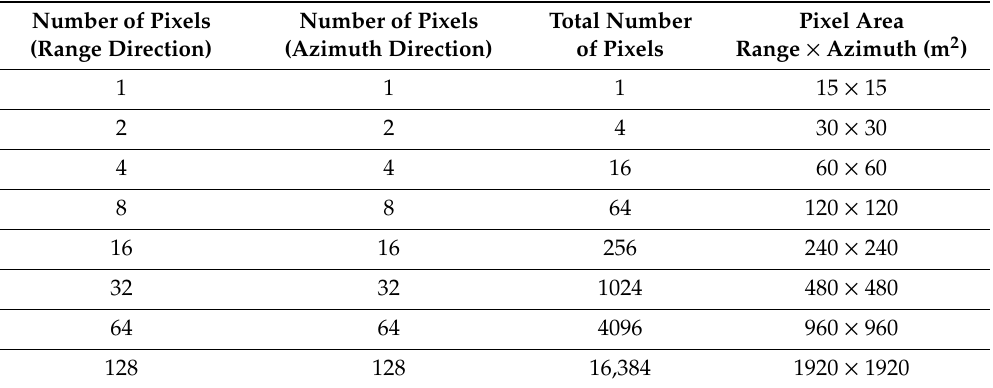
Table 5. Scaling scheme for spatial